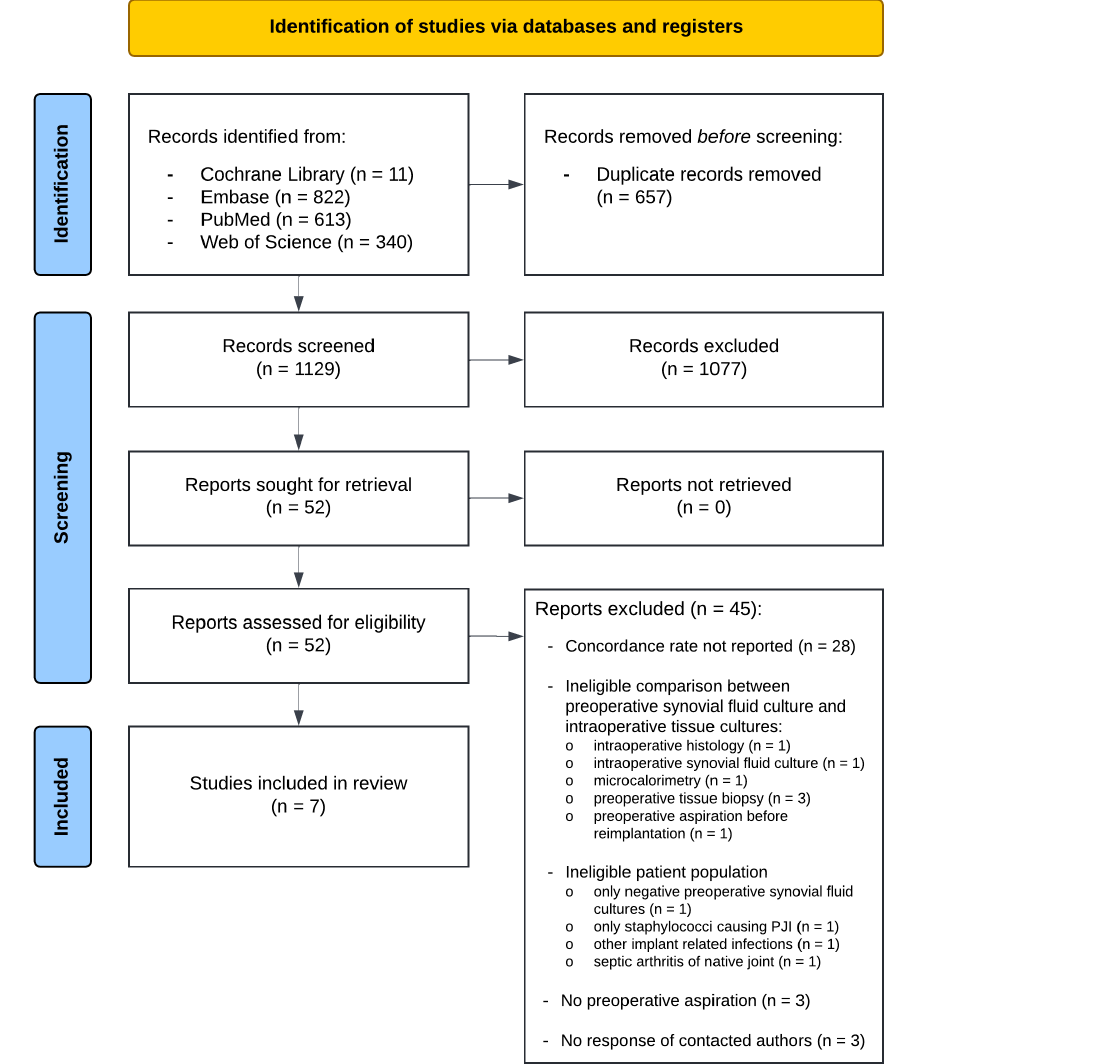
Figure 1. PRISMA flow diagram of literature search and screening